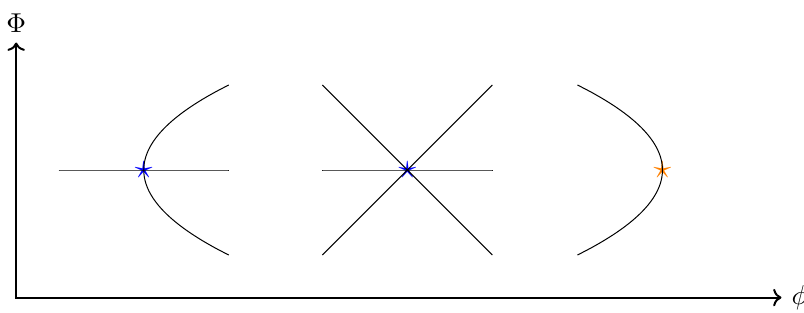
Figure 1 . In a schematic UV theory of two fields ( φ, Φ ), possible behaviors of regions of the EFT submanifold (solutions ( φ, Φ c ) of ∂V = 0 ) about points ‘ ? ’ where ∂ 2 V = 0 . For the two lefthandmost ∂ Φ ∂ Φ 2 (blue) points, ∂ 2 V = 0 , and the gradient eq. (5.9) is ill-defined. Generically, different branches ∂φ∂ Φ of solution will meet. Φ c may or may not be analytic in φ on each branch at this point. For the righthandmost (orange) point, ∂ 2 V 6 = 0 , and the gradient eq. (5.9) diverges. Φ c ceases to be an ∂φ∂ Φ analytic function of φ . See appendix C for a fuller